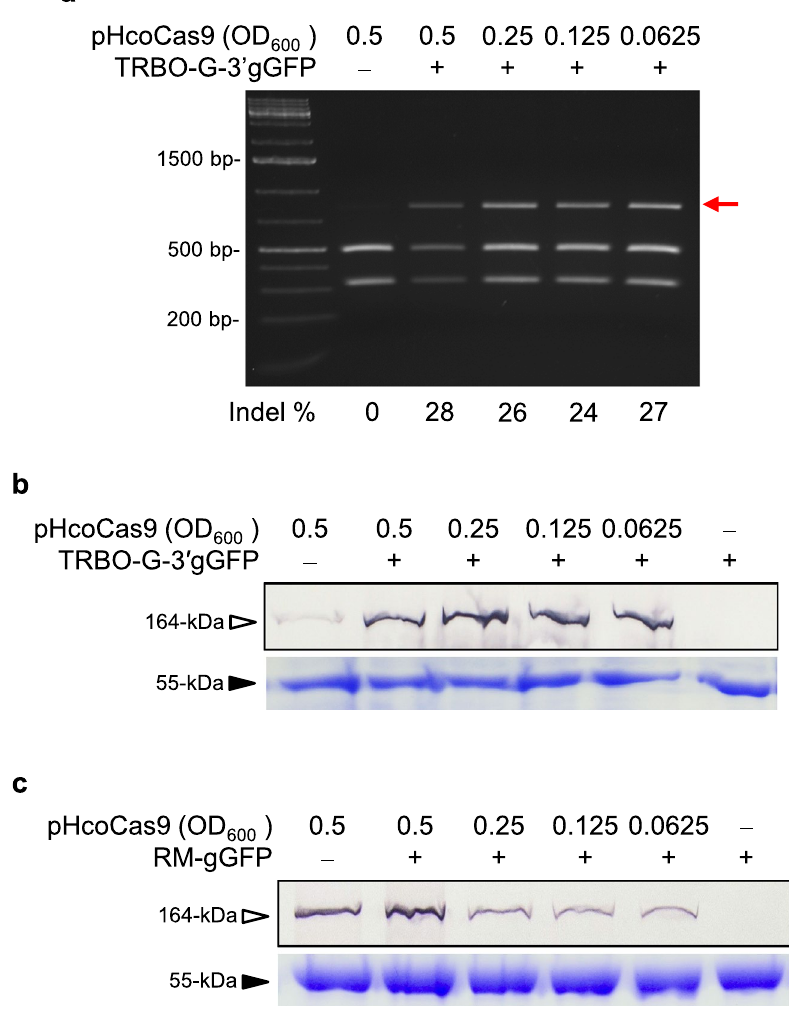
Figure 3. Cas9 protein accumulation and its catalytic activity with decreasing concentrations of pHcoCas9. ( a ) Bsg I restriction digest assay of transgenic 16c plants co-infiltrated with cultures of TRBO-G-3 ′ gGFP at OD 600 0.5 and pHcoCas9 using OD 600 values of 0.5, 0.25, 0.125, and 0.0625. Agroinfiltrated N. benthamiana leaf tissue was sampled at 7 dpi. The red arrow indicates indel containing DNA. ( b,c ) Cas9 (164-kDa) expression was analyzed at 7 dpi using western blotting of infiltrated plants using concentrations of 0.5, 0.25, 0.125, and 0.0625 gGFP delivery constructs in the top panels. Protein loading controls were assayed through Coomassie Blue protein staining and visualization of Rubisco (55-kDa). ( b ) pHcoCas9 co-infiltrated with TRBO-G-3 ′ gGFP, a TMV replicase-producing construct. ( c ) pHcoCas9 co-infiltrated with the TRBO replicase mutant (RM) construct